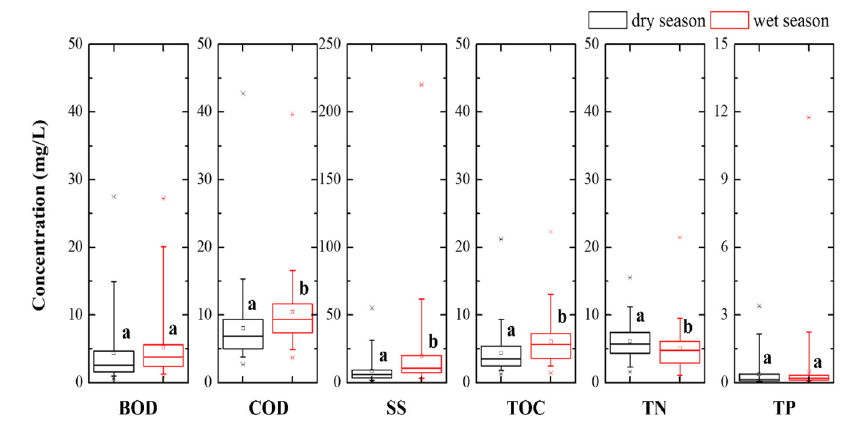
Figure 2. Boxplot of the concentration of organic (BOD, COD), particulate (TOC, SS), and nutrient (TN, TP) pollutants in coastal streams according to seasons. Lowercase letters ( a , b ) indicate significantly different groups ( p < 0.05, n = 96).